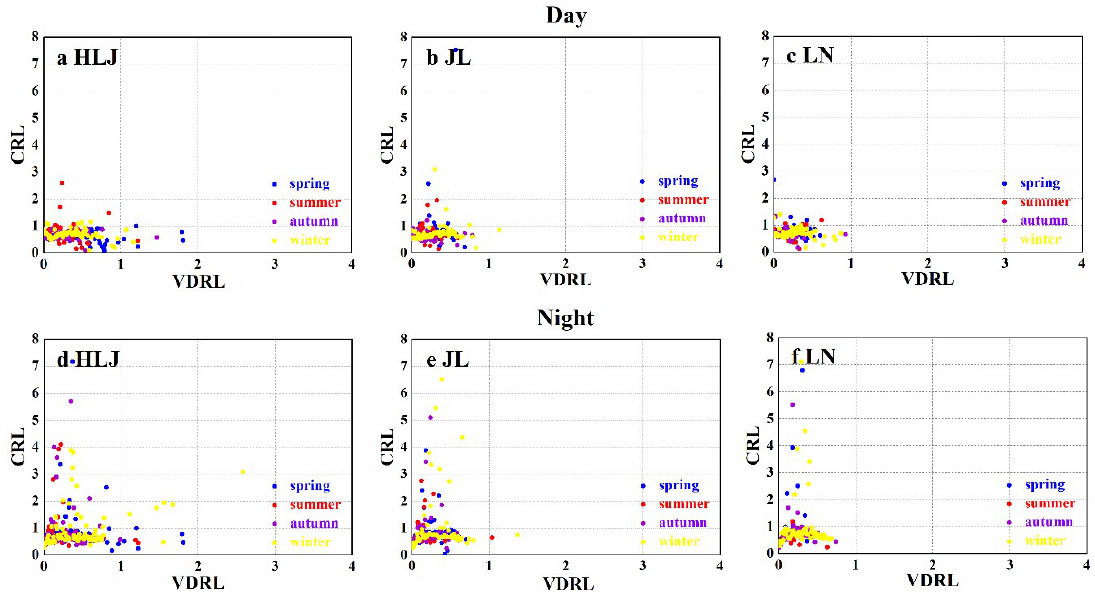
Figure 12. The correlation between PAODL and N over NEC. Where, ( a , d ) represent HLJ, ( b , e ) represent JL, and ( c , f ) represent LN.